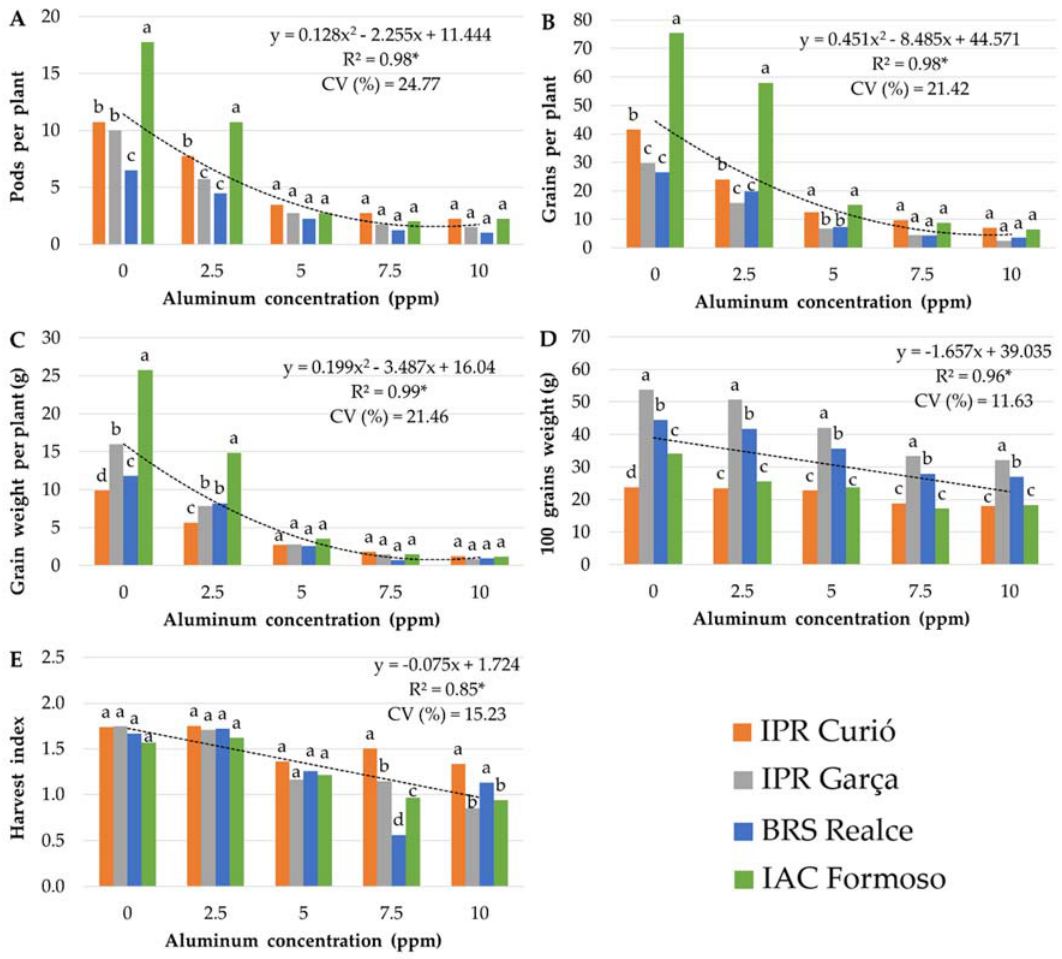
Figure 2. Yield components of common bean cultivars at increasing Al concentrations in nutrient solution. ( A ) number of pods per plant (PN); ( B ) number of grains per plant (GN); ( C ) grain weight per plant (g) (GW); ( D ) 100 ‐ grain weight (g) (W100); ( E ) harvest index (HI); CV (%) = coefficient of variation. Means followed by the same letter did not differ significantly between cultivars within each Al concentration by the Scott–Knott test ( p ≤ 0.05). * significant regression analysis at 5% probability.